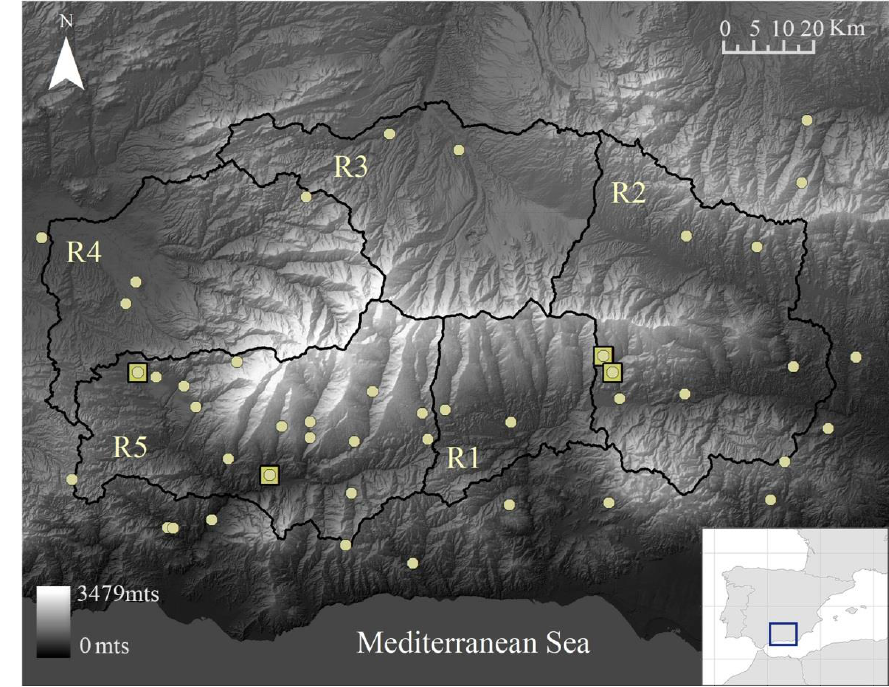
Figure 1. Location of the Sierra Nevada Mountain Range in Spain. The weather station network used in this study for measuring precipitation (yellow circle) and temperature (yellow square), and the limits of the five regions into which the study area was divided for the spatial analysis: Adra (R1), Andarax (R2), Fardes (R3), Genil (R4), and Guadalfeo (R5). Table 1. Summary of the selected characteristics of each region (see Figure 1) in the study area (SN), together with the observed mean annual trends for the climate variables during the reference period 1961–2000. The trend analysis results are defined according to the Mann-Kendall test as having either (1) excellent significance, 99% (***); (2) good significance, 95% (**); (3) acceptable significance, >90% (*); or (4) no significance, less than 90% (+) [12,31].